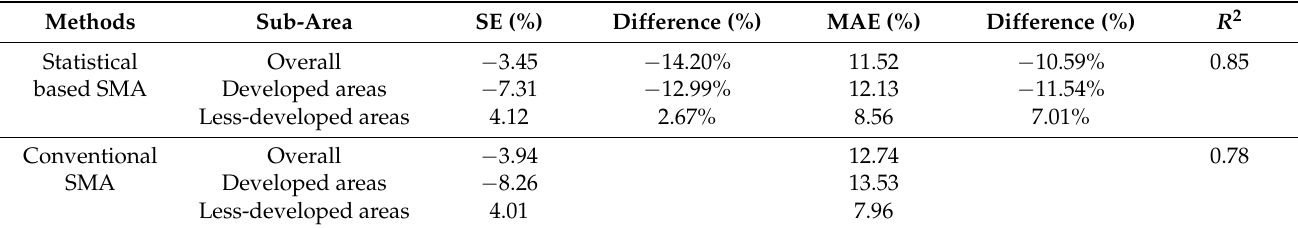
Figure 7. Sample points over the study area. Table 1. Accuracy assessment of impervious surfaces derived with the proposed method and conventional SMA.